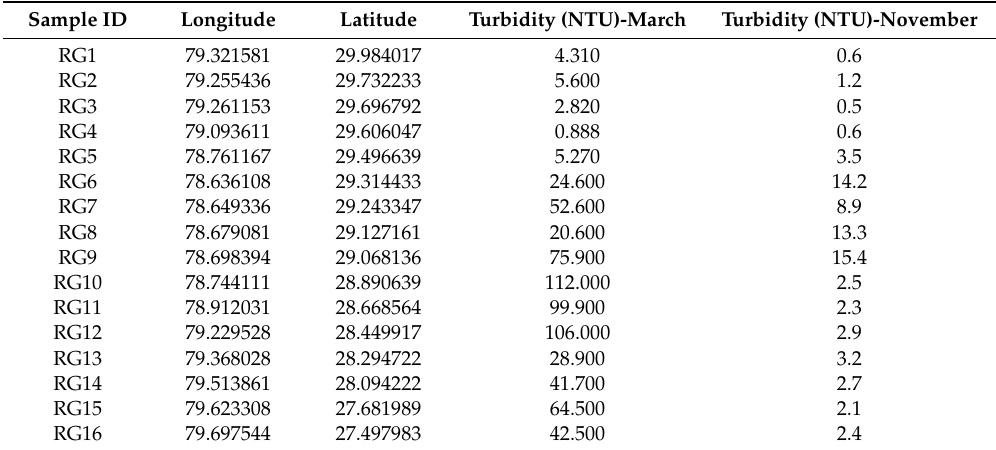
Table 2. Sampling sites description with insitu concentration of